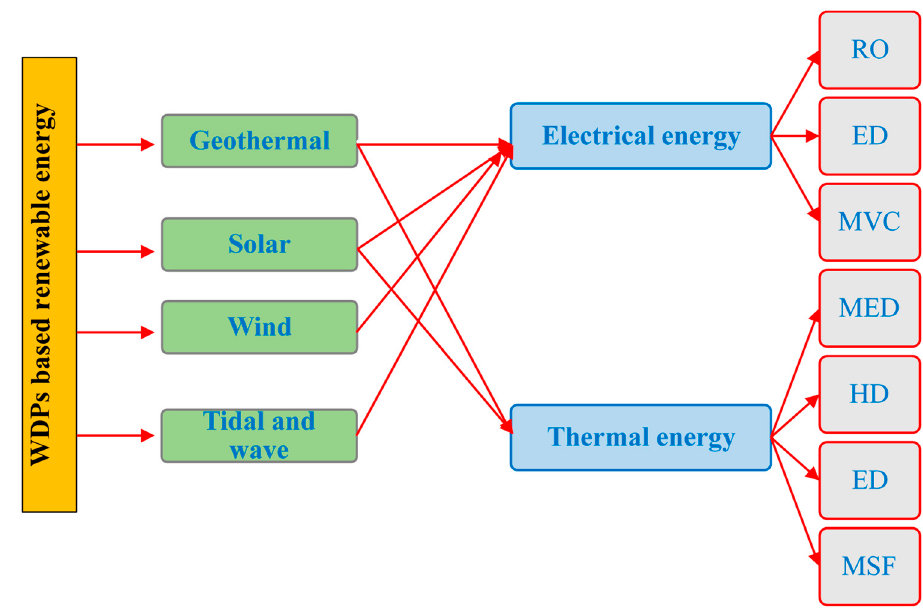
Figure 2. Possible pathways for renewable-energy-driven WD techniques.